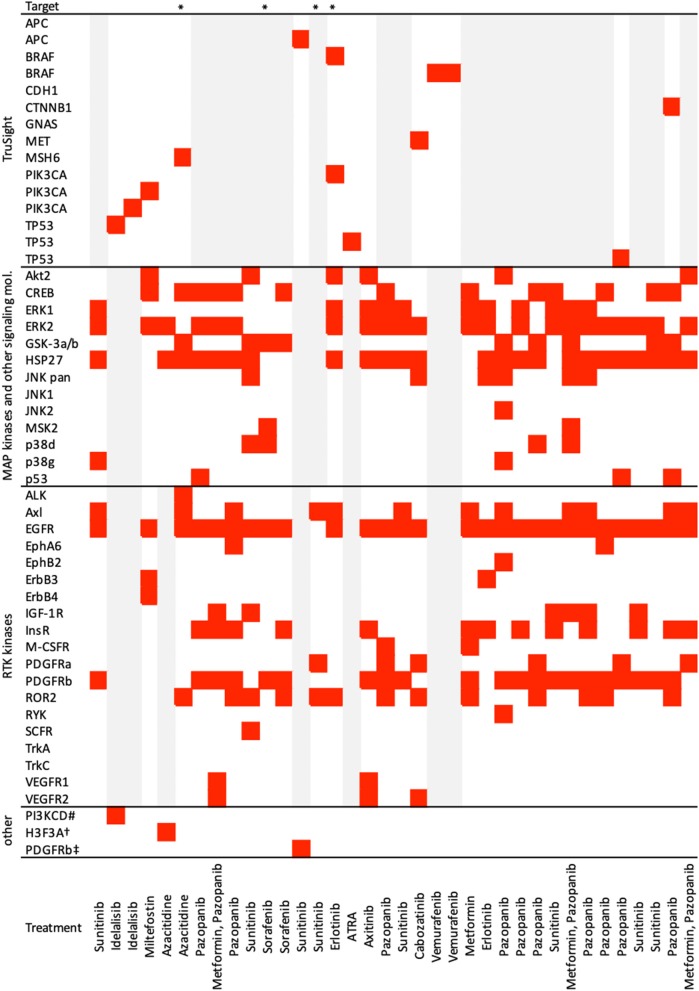
Results of biological examinations and treatment summary. Figure shows findings of biological tissue examination and drugs selected in patients on targeted (TARG) management. Other concomitant medications are not indicated here. *Treatment classified as targeted retrospectively, sensitivity analysis performed; #germinal mutation, c.935C>G, Sanger seq.; †c.83A>T/p.K28M, Whole exome sequencing; ‡immunohistochemistry; gray bars—not done.